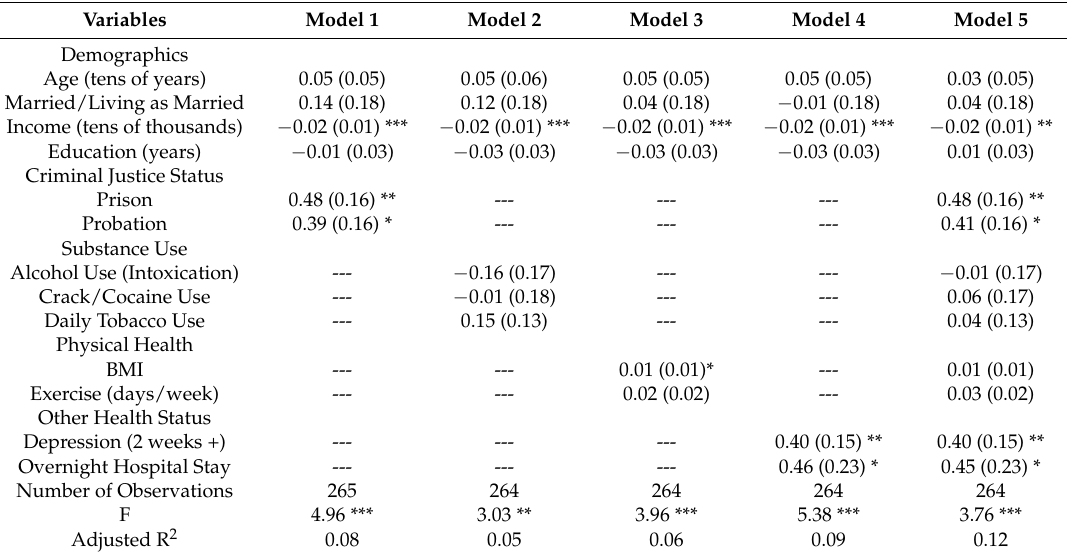
Table 5. Regression predicting health matters mean encouragement to improve health at follow-up with baseline demographic and health status/behavior measures.